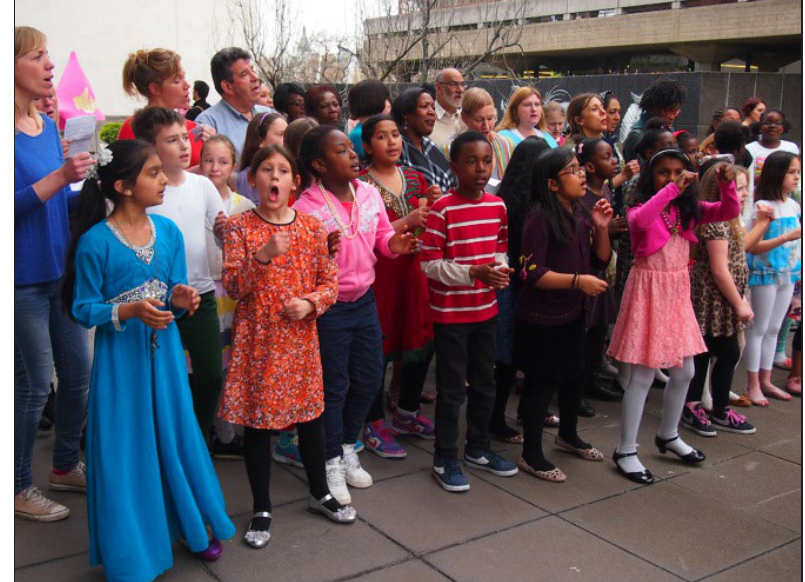
Figure 8: Davina Drummond, The Mother Song , Hayward Gallery, 2014.